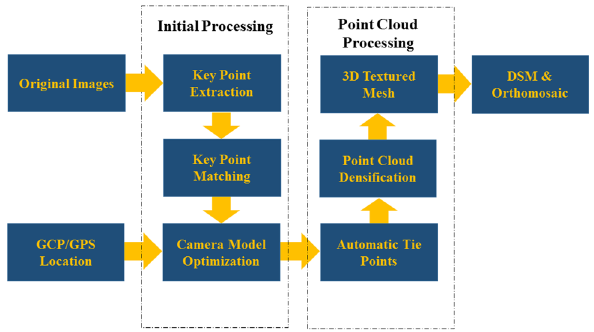
Fig. 6 Processing flow based on